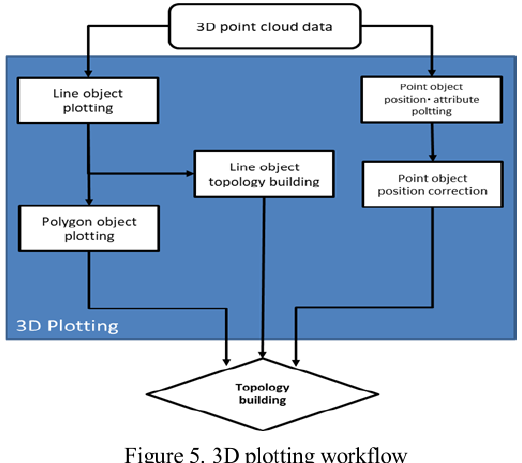
Figure 5. 3D plotting workflow